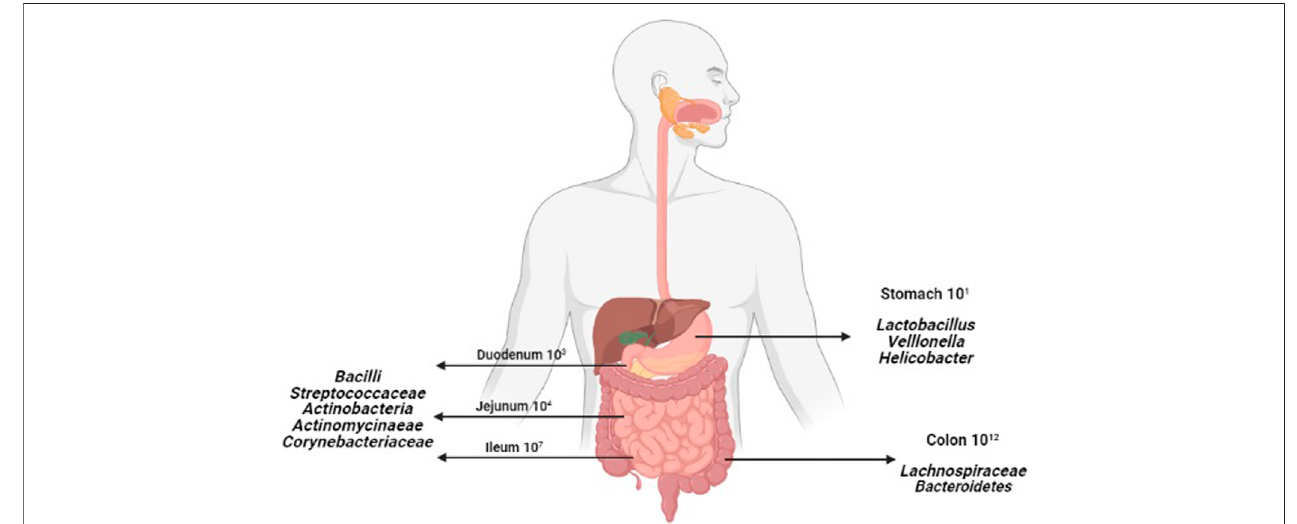
FIGURE 1 | Variations in the number and composition of microbiota across the